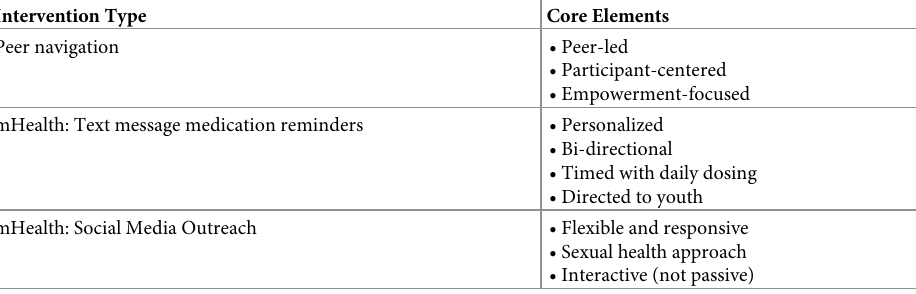
Table 1. Core intervention elements, iCARE